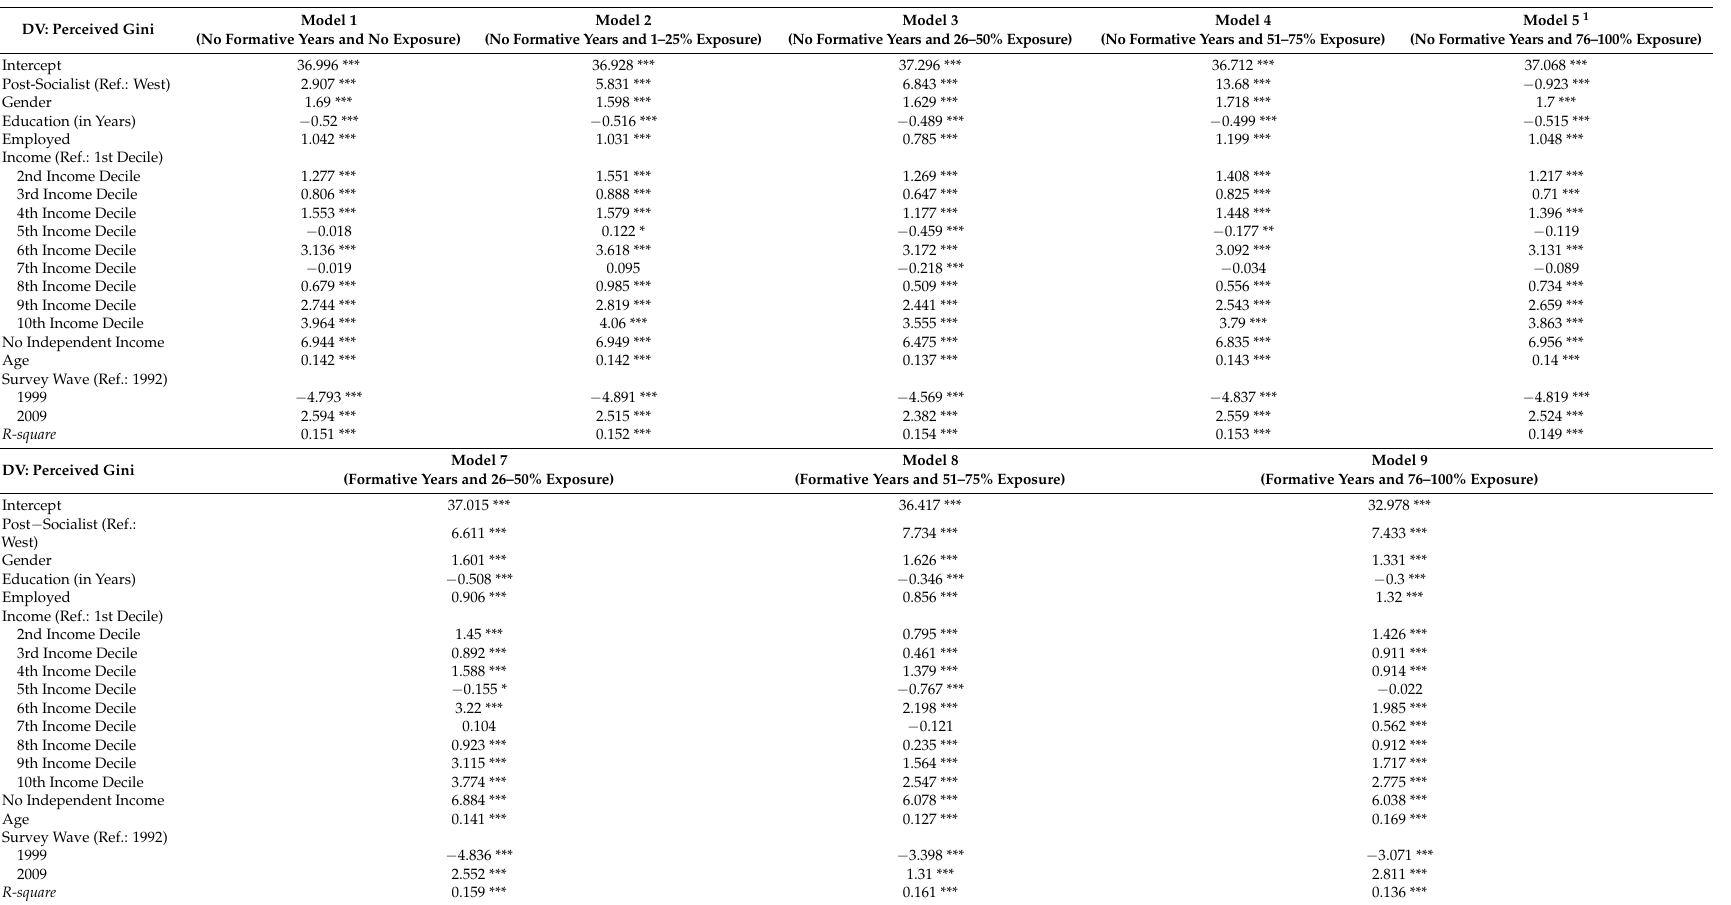
Table A12. Bootstrapped OLS regression models to explain the perceived Gini by exposure rate and formative years (corresponding with Figure